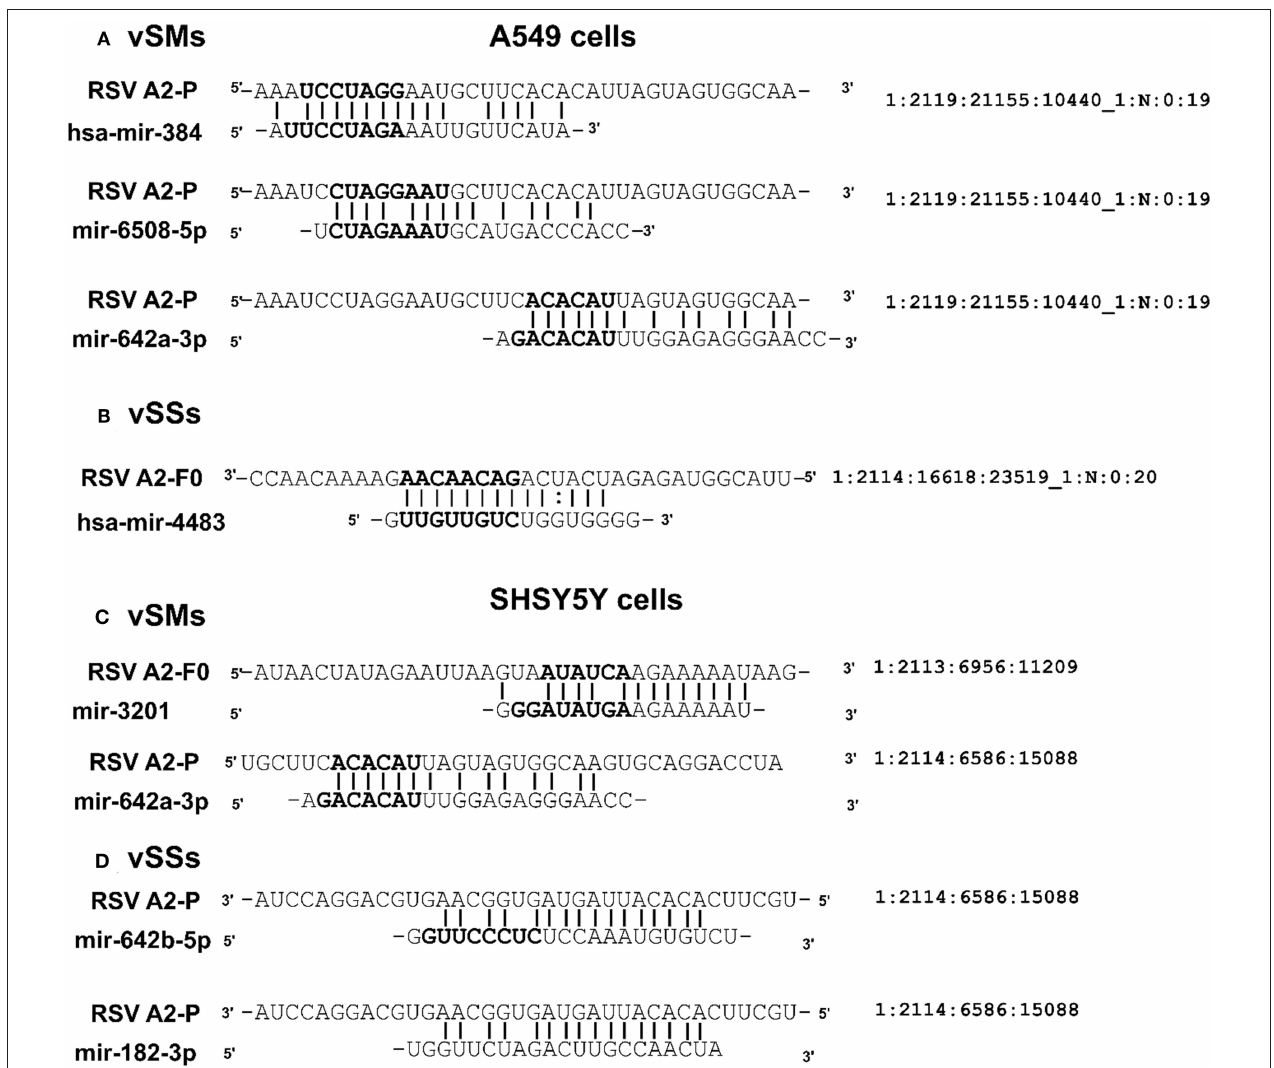
FIGURE 5 | Small RNA from RSV-infected respiratory epithelial (A549) (A,B) or neuronal (SHSY5Y) (C,D) cells were sequenced on an Illumina MiSeq. Alignments show RSV vSMs or vSSs in bold.